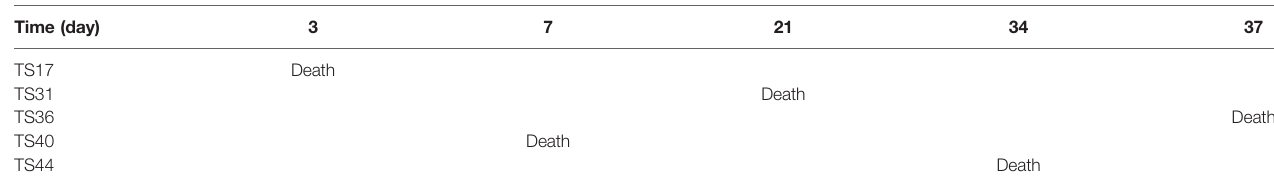
TABLE 2 | The death after the fi rst